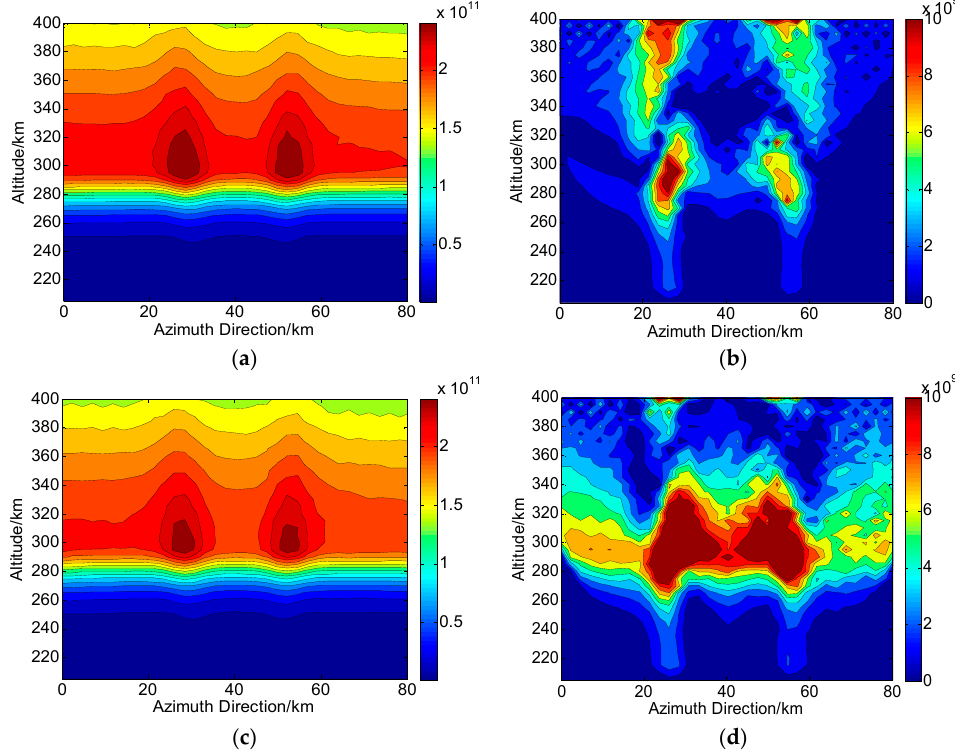
Figure 5. Two-dimensional CIT reconstructions without system errors in Changbai. ( a , c ) are the reconstructed results based on proposed and traditional CIT methods, respectively. ( b , d ) are the corresponding absolute deviations between the true and reconstructed results. The unit of the electron density is 3 electrons m − ⋅ .